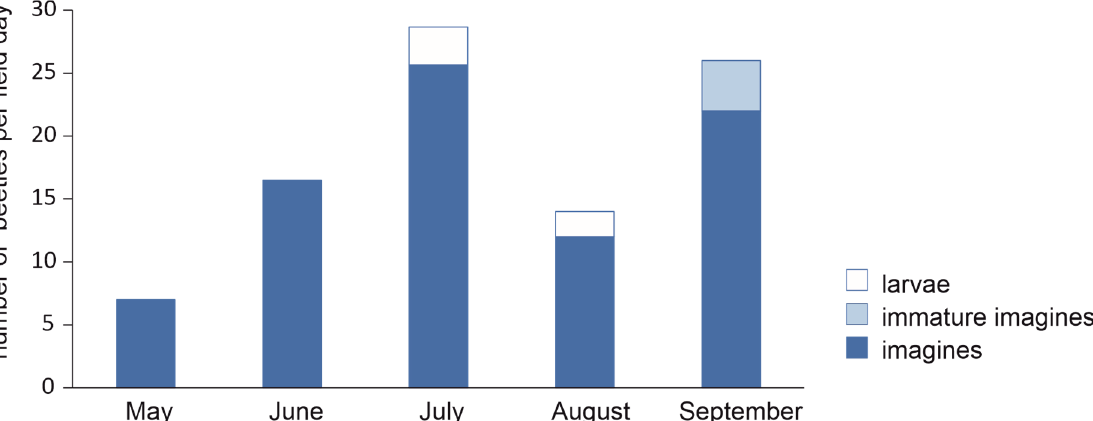
Figure 7. Seasonality of Pterostichus adstrictus in the Kaunertal, shown by caught/observed beetles in 2009 and 2010, excluding catches by pitfall traps.